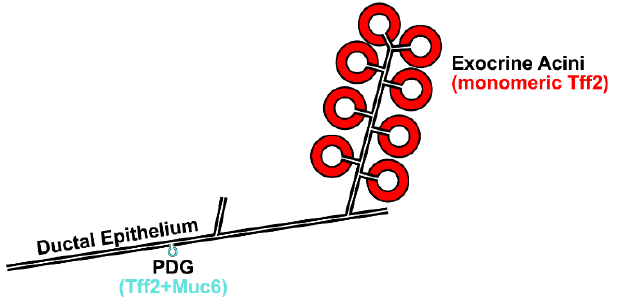
Figure 10. Schematic structure of the exocrine pancreas (not drawn to scale). Ductules from a group of acini converge to an intralobular duct, which is connected to interlobular and collecting ducts. Shown is the predominant synthesis of Tff2 in the acini (red), and its trace amount co-expression, together with Muc6, in the pancreatic duct glands (PDGs, turquoise). Of note, the total mass of PDGs is much smaller when compared with that of the exocrine acini.